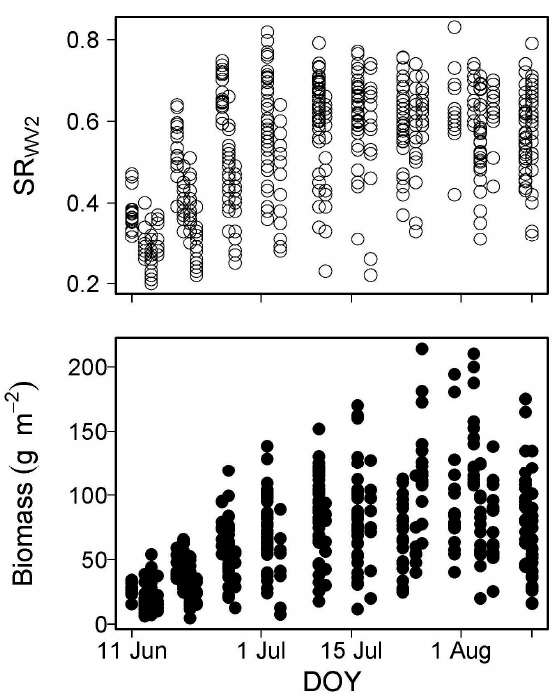
Figure 2. Biomass (g m − 2 ) of halophytic graminoids (filled symbols) and plot-level NDVI values (open symbols) by season date at the Colville River Delta, Alaska, 2012–2015. NDVI values plotted here were derived at WorldView-2 band definitions using a handheld spectrometer. Dates are representative of non-leap years (i.e., 2013–2015).